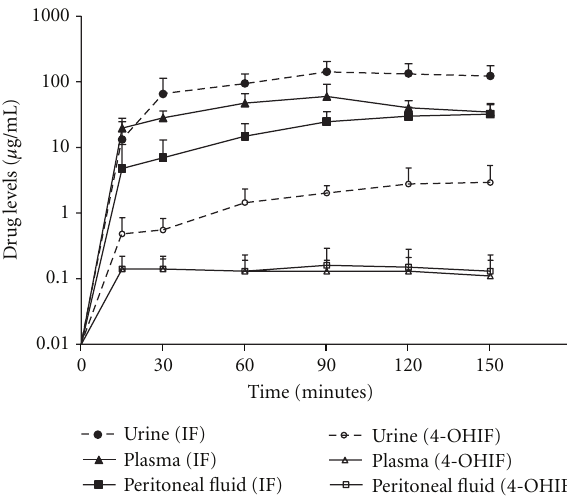
Figure 3: Plasma, peritoneal fluid, and urine concentrations of ifosfamide and 4-hydroxyifosfamide over a 90-minute infusion and 60-minute period of observation.